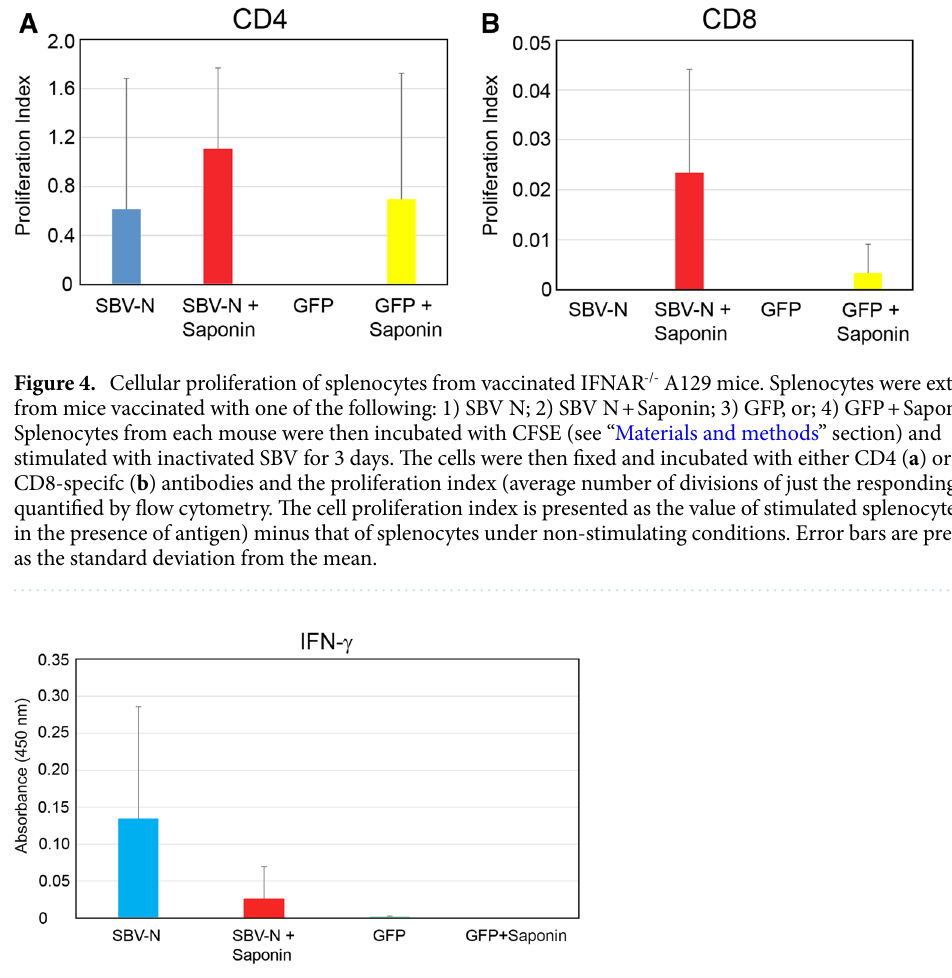
Figure 5. Secreted IFN-γ from splenocytes of vaccinated IFNAR -/- A129 mice. Splenocytes were extracted from mice vaccinated with one of the following: 1) SBV N; 2) SBV N + Saponin; 3) GFP, or; 4) GFP + Saponin. The cells were then isolated and stimulated ex vivo using inactivated SBV. Detection of secreted IFN-γ was measured using ELISA and measured using a spectrophotometer at 450 nm. Error bars are presented as the standard deviation from the